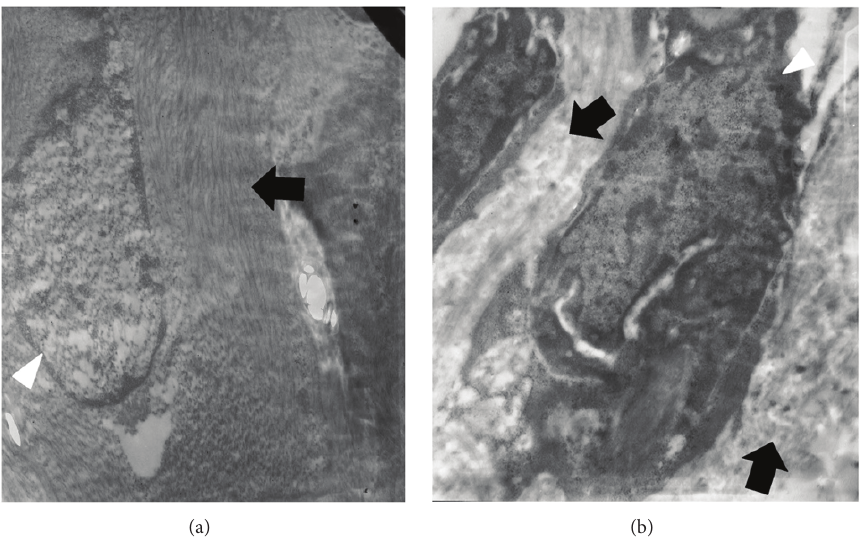
Figure 3: Collagen fibrils in myometrium and fibroids. Comparison of collagen fibril organization in the extracellular matrix of myometrium or uterine fibroid using electron microscopy. (a) Myometrium. Collagen fibrils are tightly packed and well-aligned, as shown by the black arrow. The nucleus is denoted by the white arrowhead. Magnification = 11,500x. (b) Fibroid. The collagen fibrils are randomly aligned and widelyspaced,asshownbyblackarrows.Thenucleusisnotchedanddenotedbythewhitearrowhead.Magnification=15,500x.Representative sections on samples harvested from a single